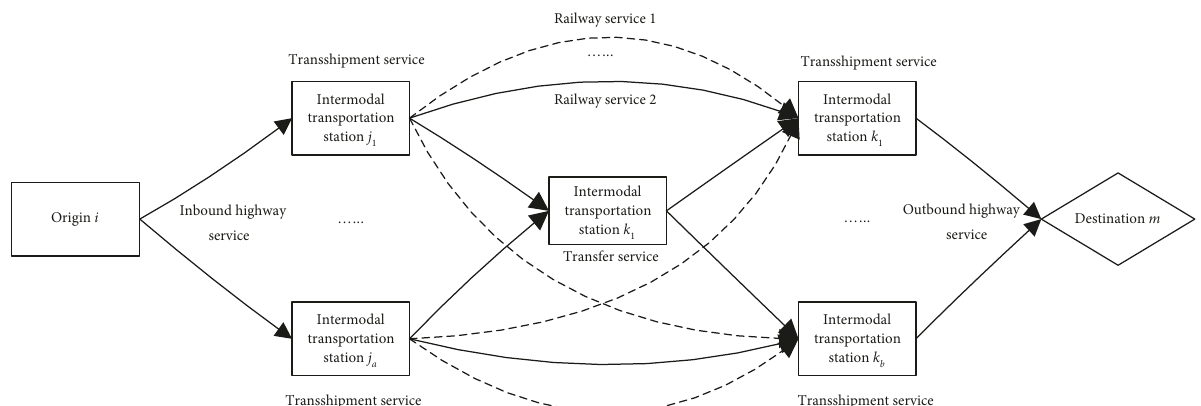
Figure 2: Schematic diagram of the railroad intermodal transportation service